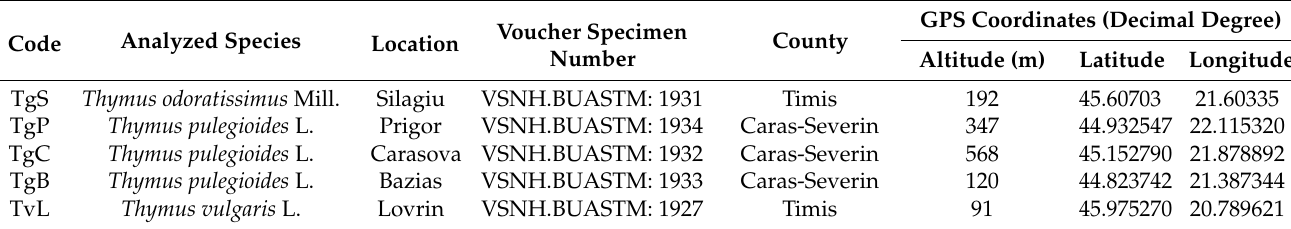
Table 5. Species of the genus Thymus analyzed and their